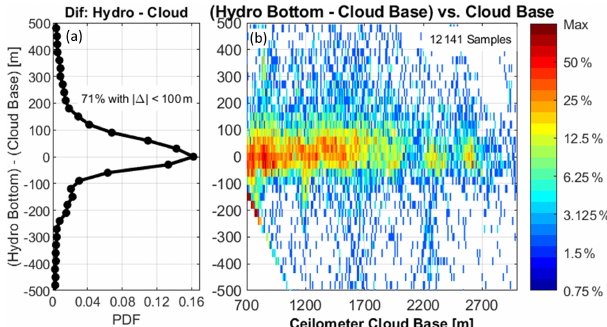
Figure 13. Difference in the hydrometeor mask QC1 column bot- tom and ceilometer cloud base height using 47d at SGP during 2018 and 2019. There were 12141 profiles with simultaneous hy- drometeor mask QC1 and ceilometer cloud bases. (a) 1D PDF of height difference defined as (hydrometeor mask column bottom) – (ceilometer cloud base) (m) with 30m resolution corresponding to radar range resolution. (b) Colors are 2D distributions of height difference vs. ceilometer cloud base. Colors represent the percent- age of occurrence relative to the cell with the maximum number of observations. The artifact at negative height differences and low ceilometer cloud base is due to the radar first range gate at